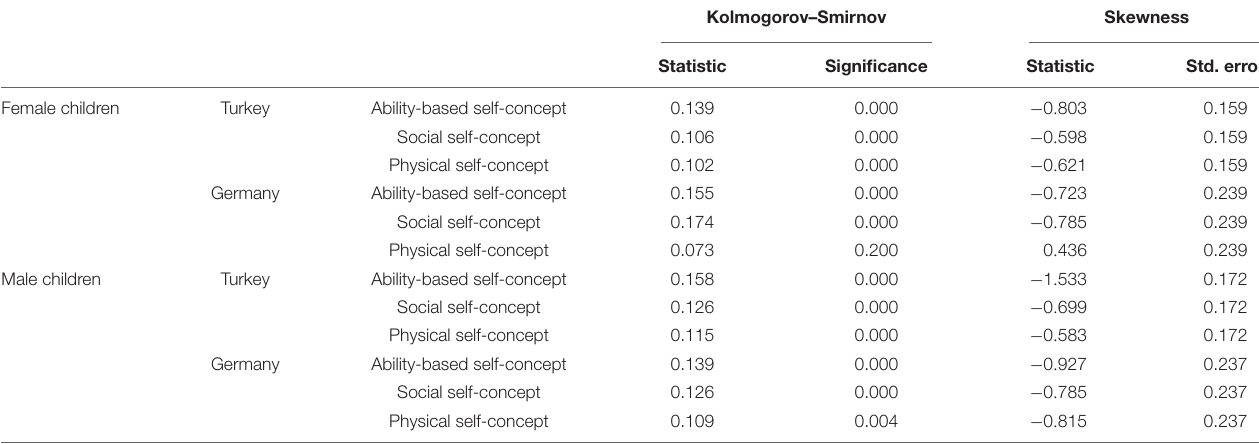
TABLE 2 | Results on the normal distribution for